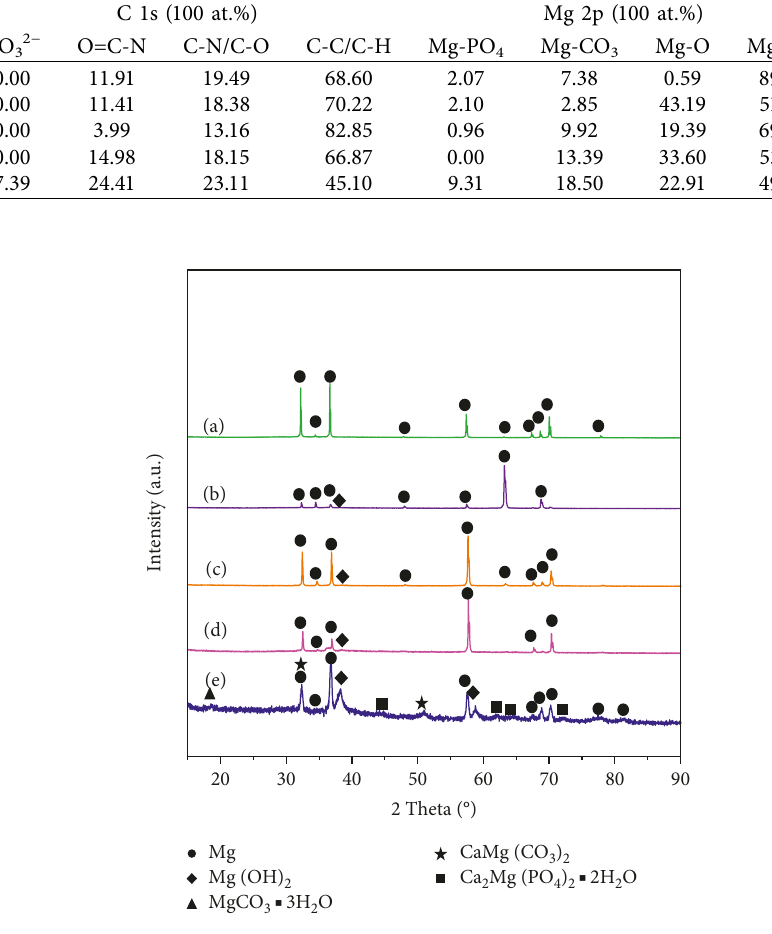
Figure 9: XRD results of the surfaces of (a) pure Mg-ER7.1, (b) Mg-3Ag-as cast, (c) Mg-3Ag-ER7.1, (d) Mg-3Ag-ER72.2, and (e) Mg-6Ag- ER7.1 after immersion test for 16 days.